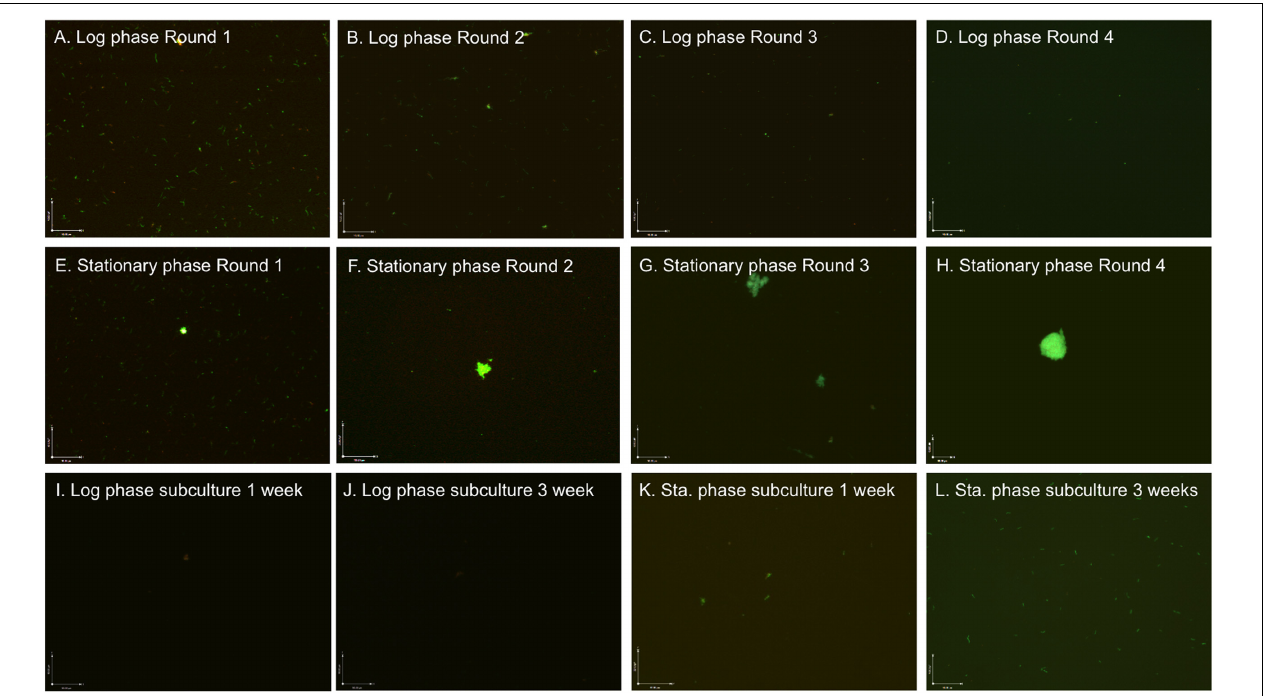
FIGURE 1 | Effect of ceftriaxone pulse dosing on 5 day old log phase and 10 day old stationary phase Borrelia burgdorferi cultures. Log phase (A–D, I, and J) and stationary phase (E–H, K, and L) B. burgdorferi cultures were treated with pulse dosing of 5 µ g/mL ceftriaxone as described in the section “Materials and Methods” followed by staining by SYBR Green I/PI assay and fluorescence microscopy at 100 × magnification. Abbreviation: Sta.,